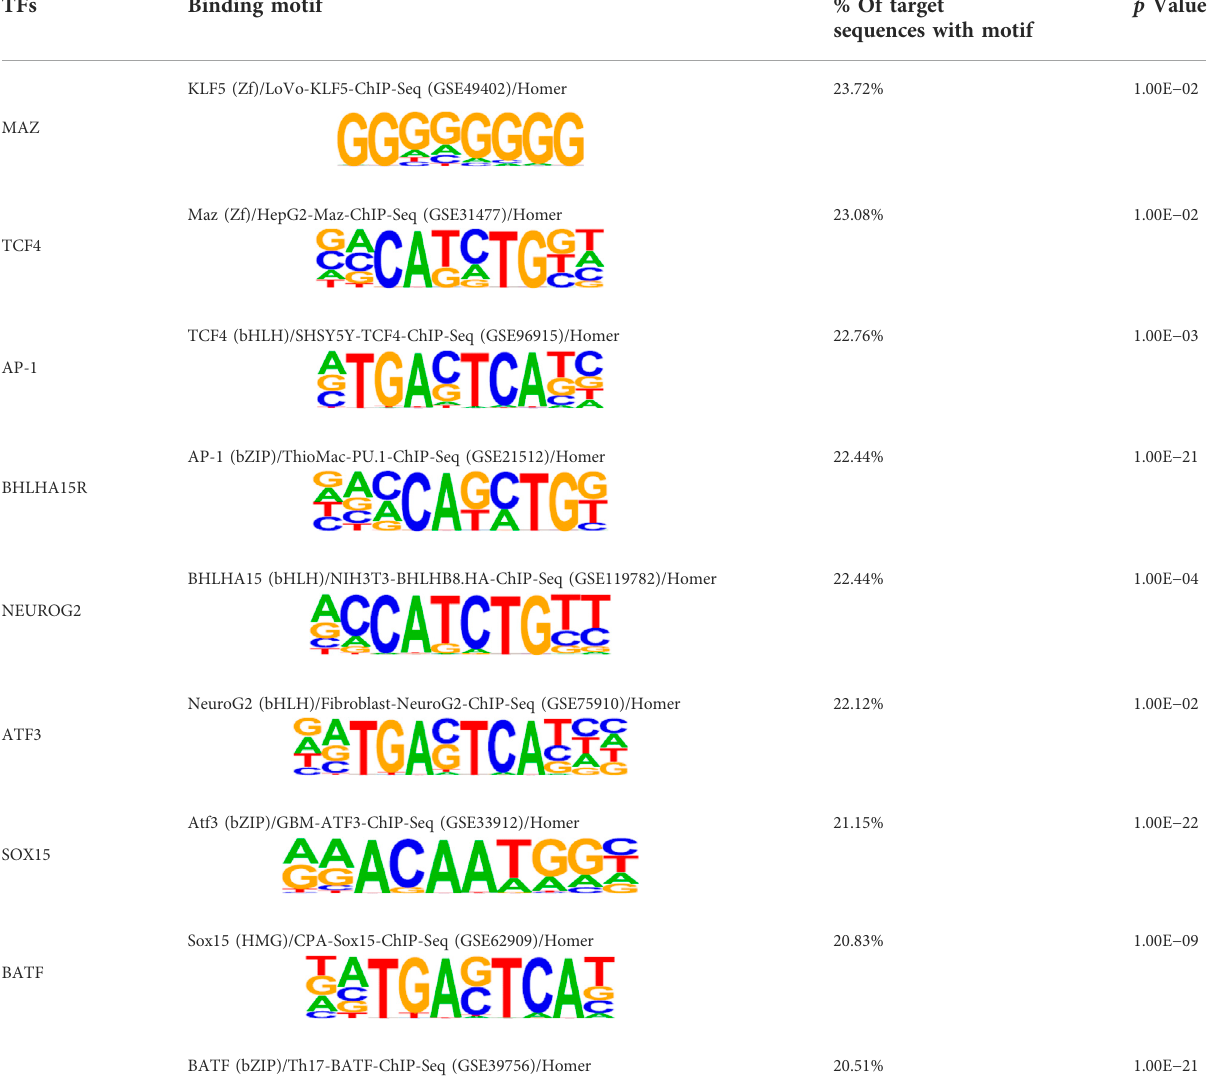
TABLE 2 ( Continued ) TFs binding homer known motifs enriched in chromatin region in response to progestin in PIS group compared to PS group from Analysis